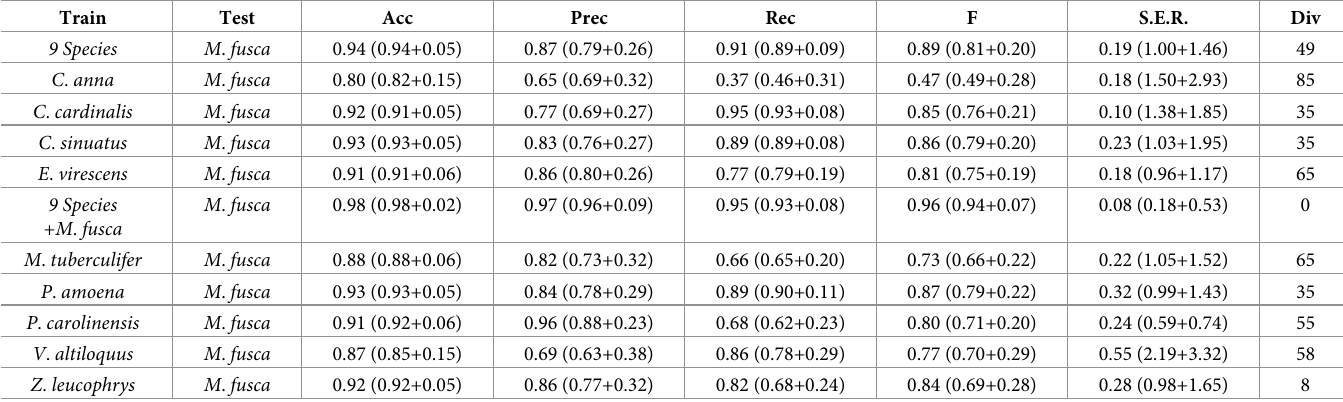
Table 2. Performance of models trained in TweetyNet for Melozone fusca .